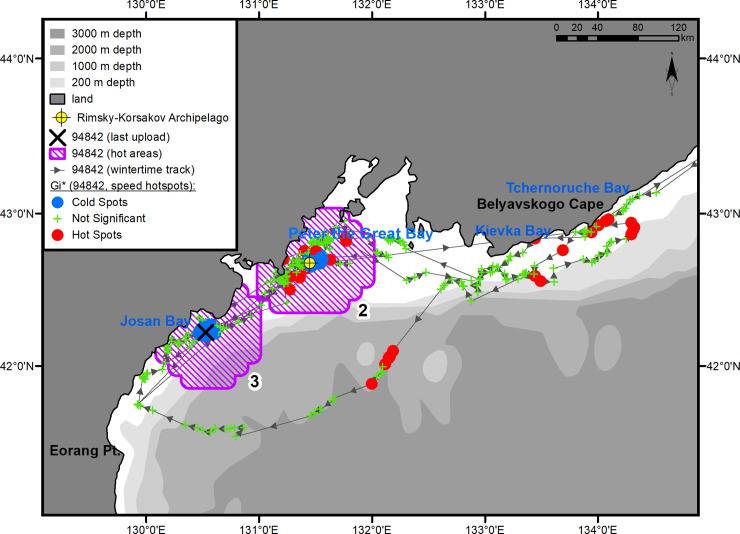
Winter habitats of underyearling female #94842.The numbers of the hot areas are the same as in Fig 1.